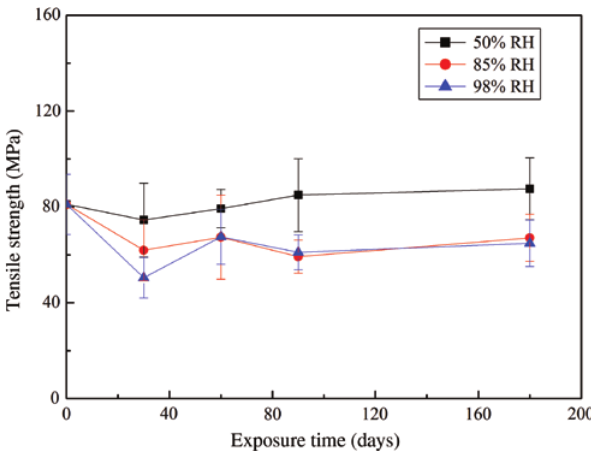
Figure 6 Variation of elongation at break as a function of exposure time of ramie fiber fabric reinforced phenolic resin samples under three humidity conditions at room